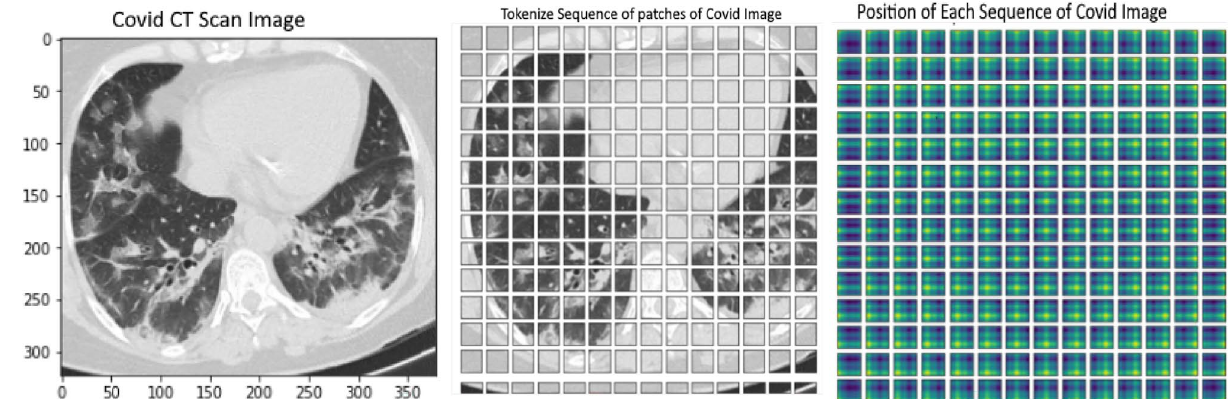
Figure 2. ( a ) COVID CT scan image, ( b ) number of patches ( c ) positional